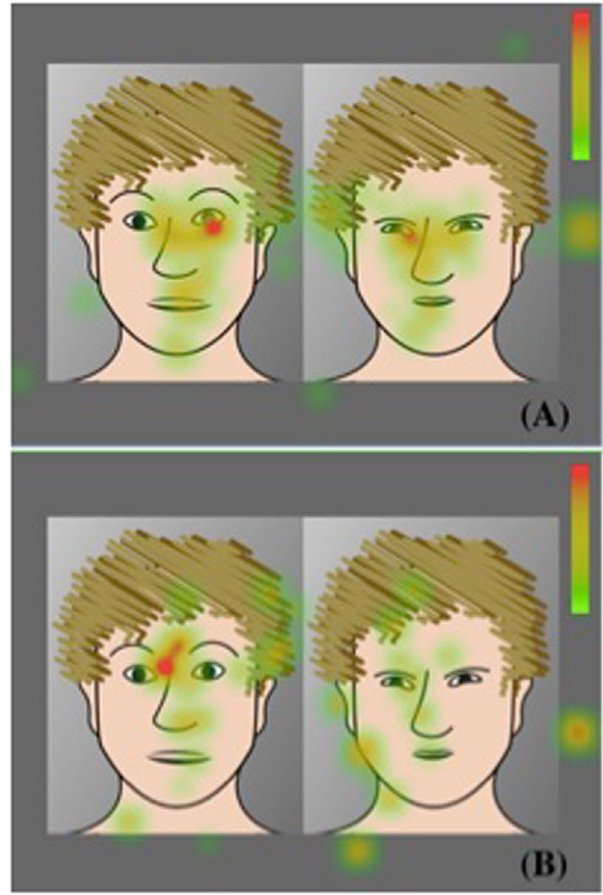
Figure 1. Visualizations (heat maps) of fixation durations. ( A , B ) Humans ( A ) and orangutans ( B ) fixate human facial expressions (fear vs. anger). While the color red marks those areas that are fixated longest, green indicates those areas that are fixated least. Important: because of copyright issues and publishing guidelines of the FACES database 63 , stimuli depicting human facial expressions are shown here only as schematic drawings, while in the study, we used the original